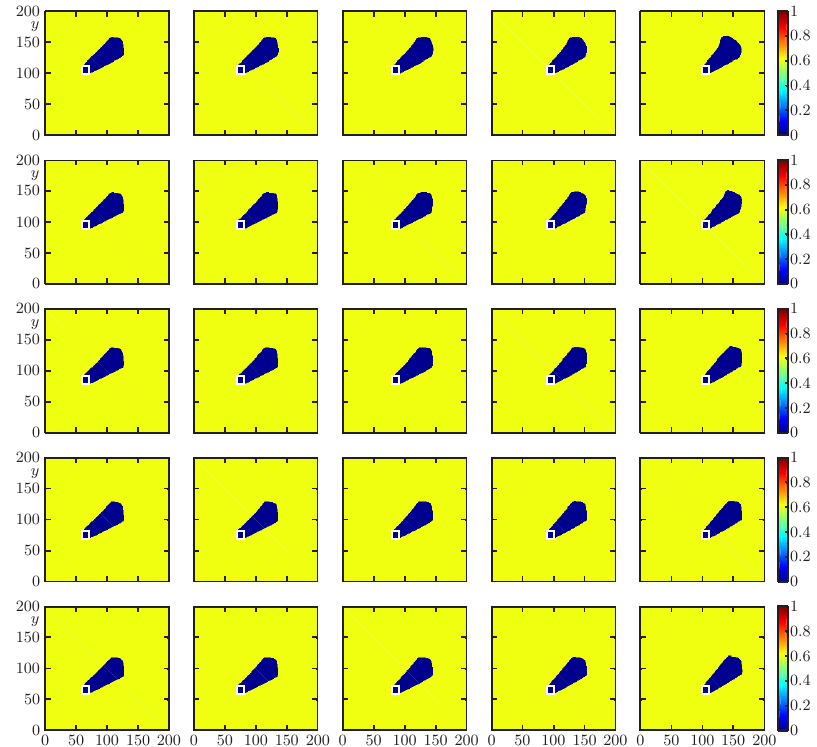
Figure 10. Scenario 3.2: simulation of fuel of a wildfire from 5 small white squares, on a domain with topography